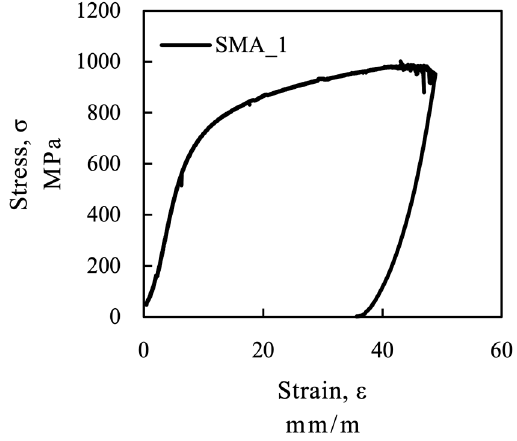
Figure 3. SMA during prestraining.